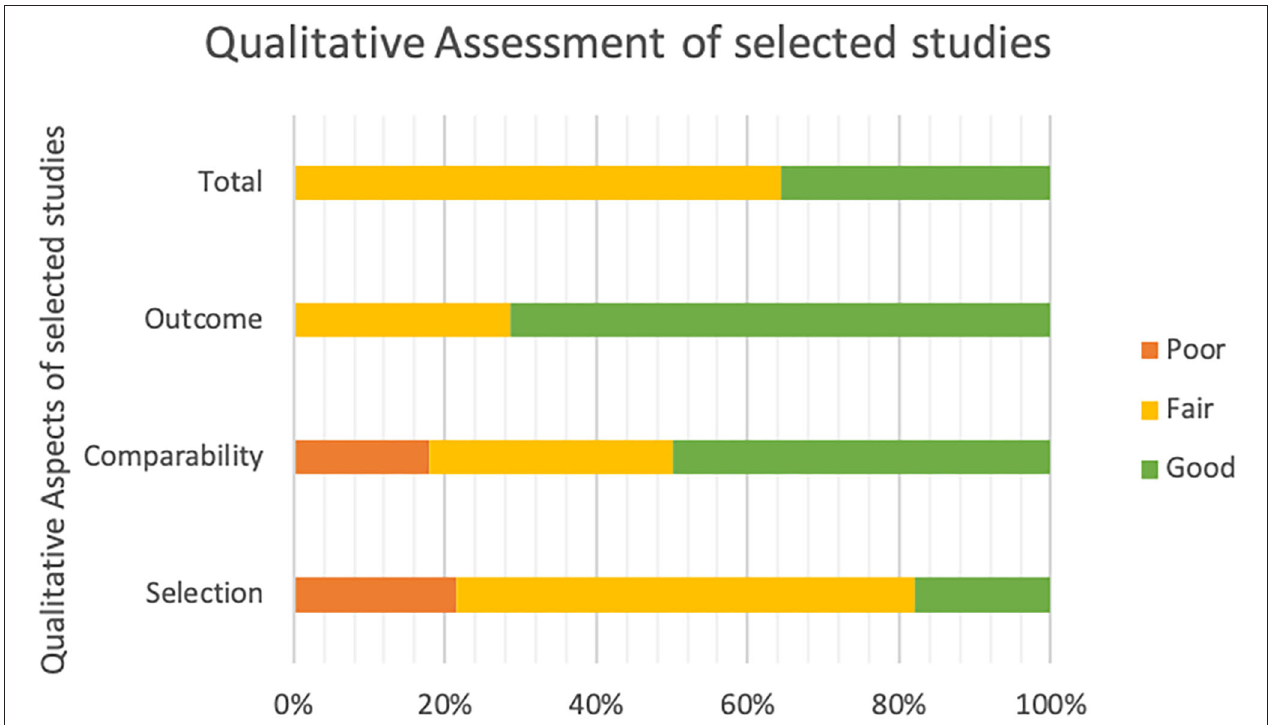
FIGURE 2 | Qualitative assessment of the 14 studies included in the narrative review. Selection: representativeness and sample size; Comparability: correspondence of the variables between age and gender; Outcome: consistency of instruments used and relevance of statistical analyses; Total: Total Quality Score.